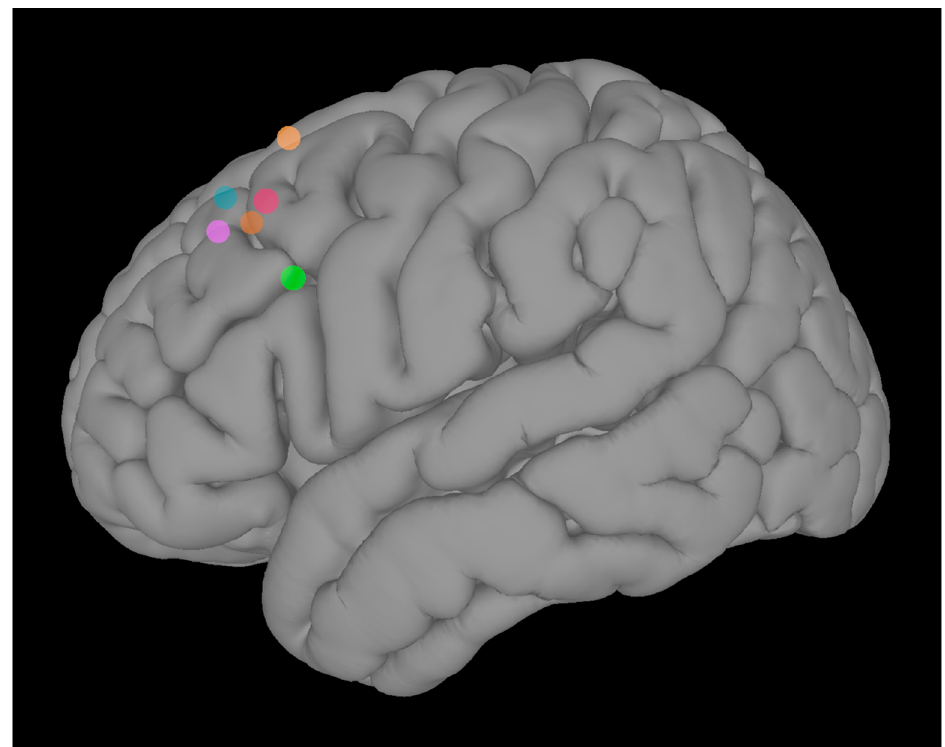
Figure 2. Individualized left dorsolateral prefrontal cortex targets.